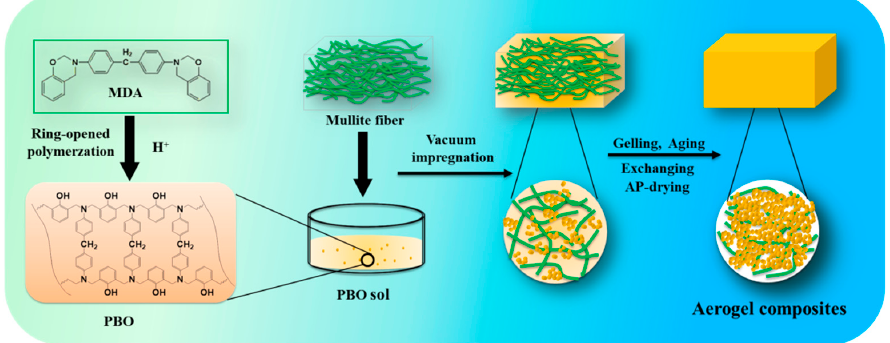
Figure 1. Illustration of the synthesis and structural composition of fiber-reinforced PBO aerogel composites.